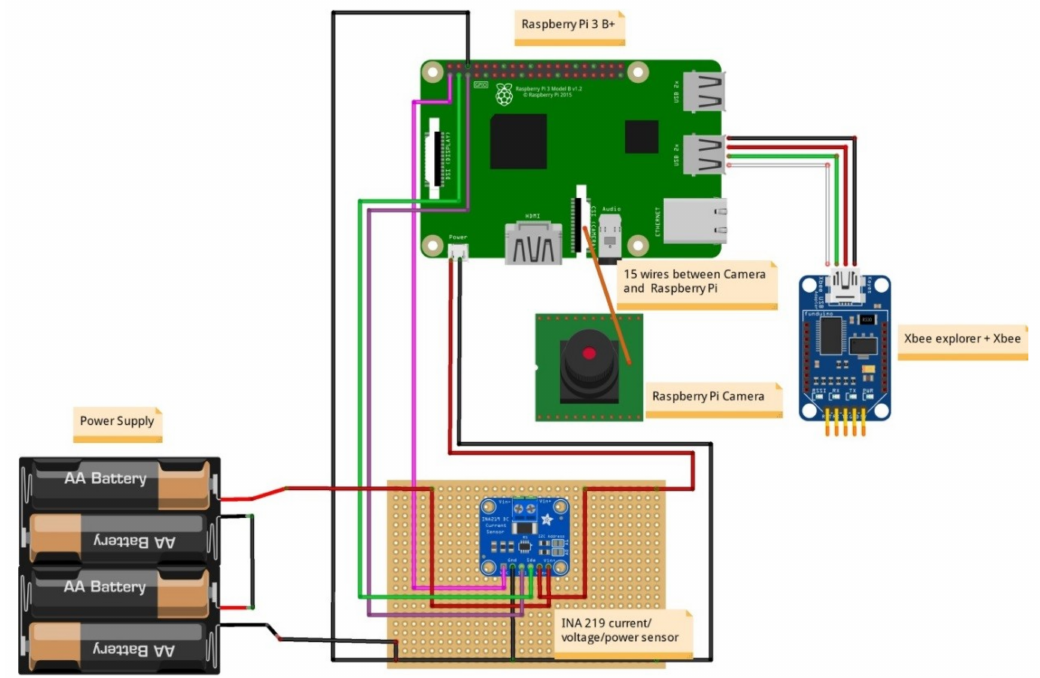
Figure 11. The MESP-R consists of a Raspberry Pi board with attached modules supporting communications, optical sensing and power consumption